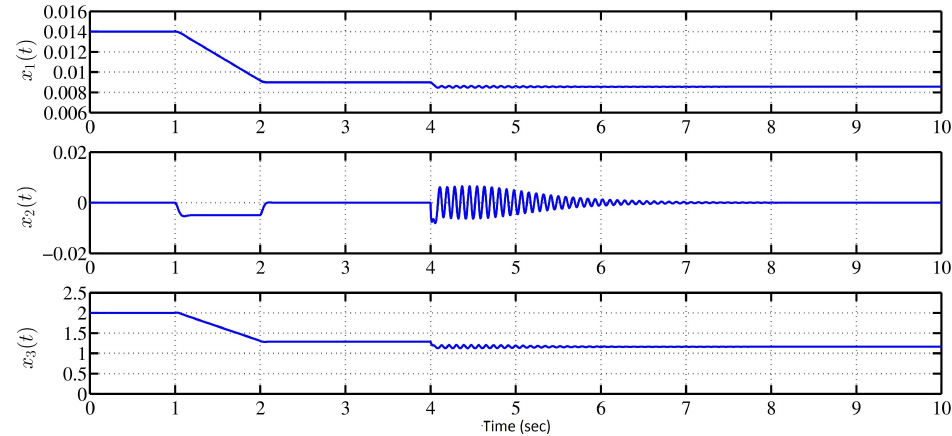
Figure 10. Response of state-variables of MLS under parametric uncertainties ( x i ( t ) , i =